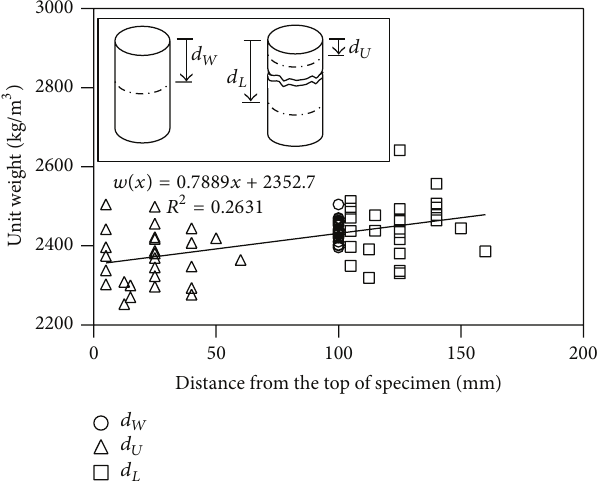
Figure 7: Unit weight distribution along the specimen